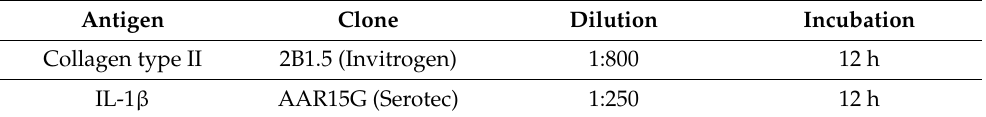
Table 2. Target antigens and antibodies used in the immunohistochemical